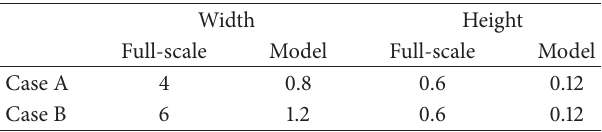
Table 1: Specifications of the windbreak fence used in the wind tunnel test (unit =